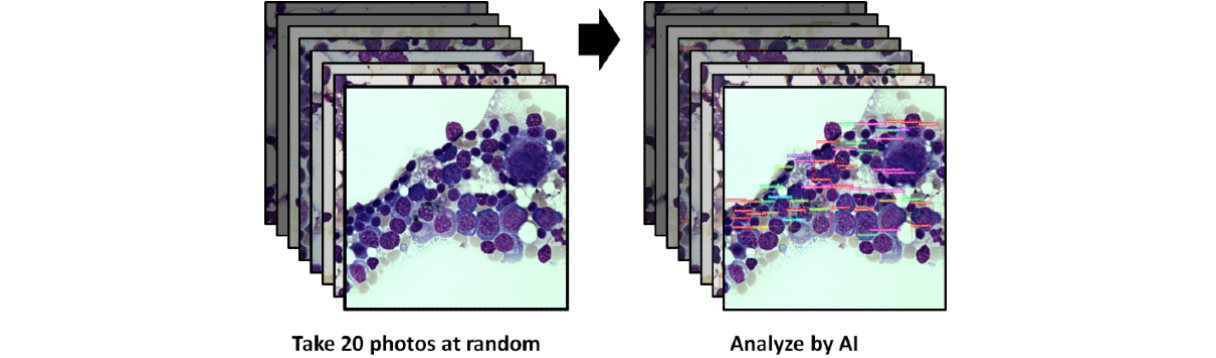
Figure 2. Artificial intelligence interpretation process. This flow chart demonstrates how to use BMSNet in clinical practice. In all, 20 photographs of each bone marrow smear slide are taken at random, and BMSNet will provide a cell-based prediction for each image. Finally, the total proportion of each category of cells is calculated based on cell